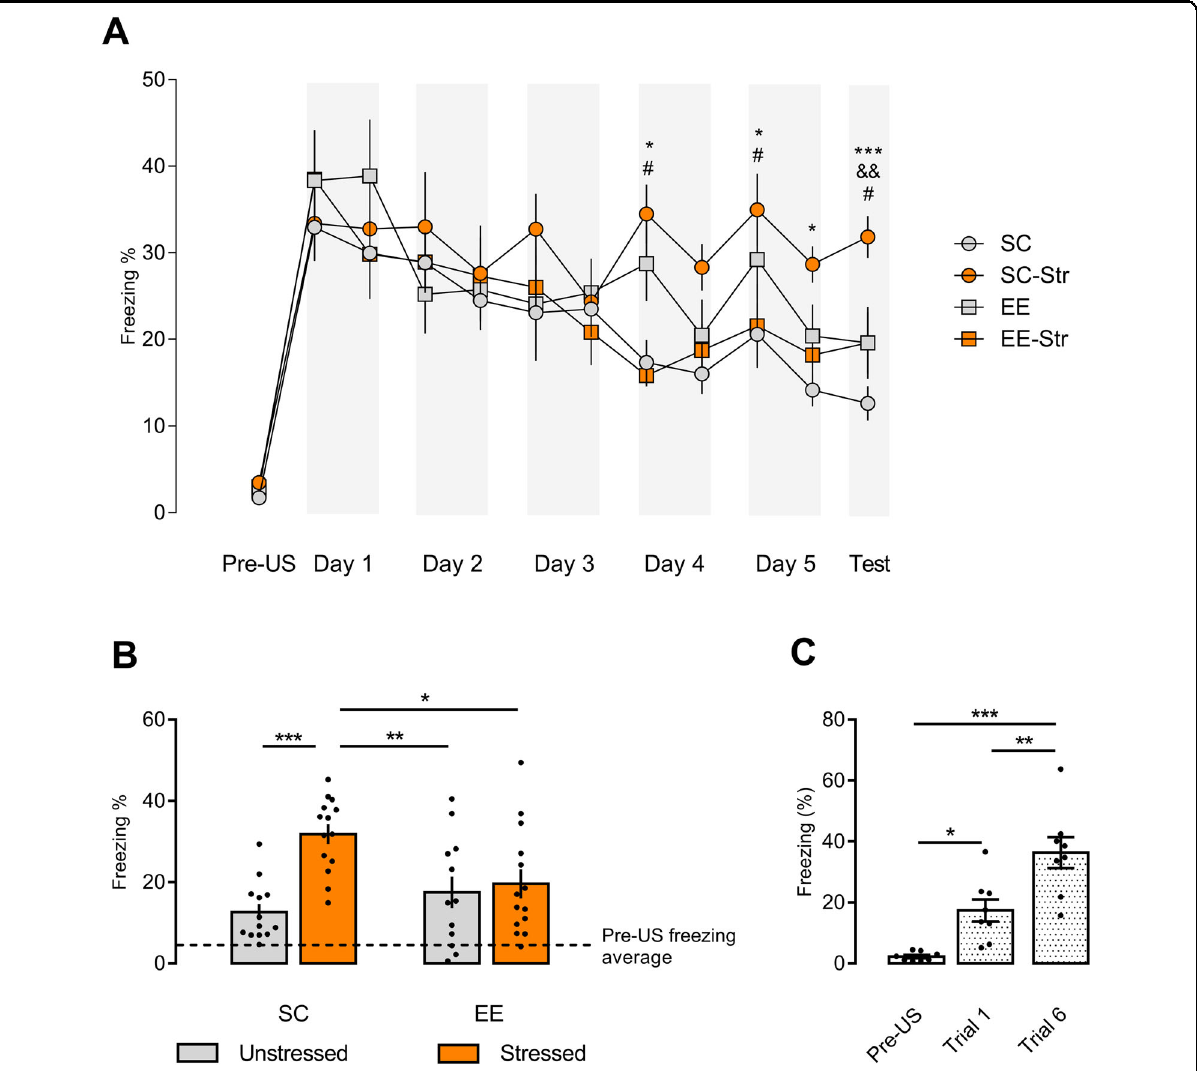
Fig. 2 EE protects against acute restraint stress effect on late fear extinction impairment. Stressed SC-housed animals (SC-Str) showed a higher percentage of freezing comparing to SC-housed, unstressed (SC) and EE-housed, stressed (EE-Str) rats on the days 4, 5 (during the initial 5 min of test session), and 6, and higher than EE-housed, unstressed animals (EE) on day 6 post-acquisition training ( A ). The column graph depicts the higher behavioral freezing response of SC-Str animals comparing to SC and EE (EE and EE-Str) rats on the extinction test ( B ). Animals placed on the unpaired arena (UA) showed a higher percentage of freezing during trial 1 than during acquisition training (Pre-US), but lower than during trial 6, when animals were placed back on the paired arena ( C ). Results are presented as mean ± SEM ( n = 8 – 14 animals per group in A ; n = 14 per group in B ; n = 8 per group in C ). Two-way ANOVA ( A , B ) and one-way ANOVA ( C ) followed by Tukey ’ s multiple comparisons test. Signi fi cance differences between groups are indicated as *, **, and *** in relation to SC ( A , B ) or in relation to Pre-US ( C ) ( p < 0.05, p < 0.01, and p < 0.001, respectively); # in relation to EE-Str ( A , p < 0.05); && in relation to EE ( A , p <